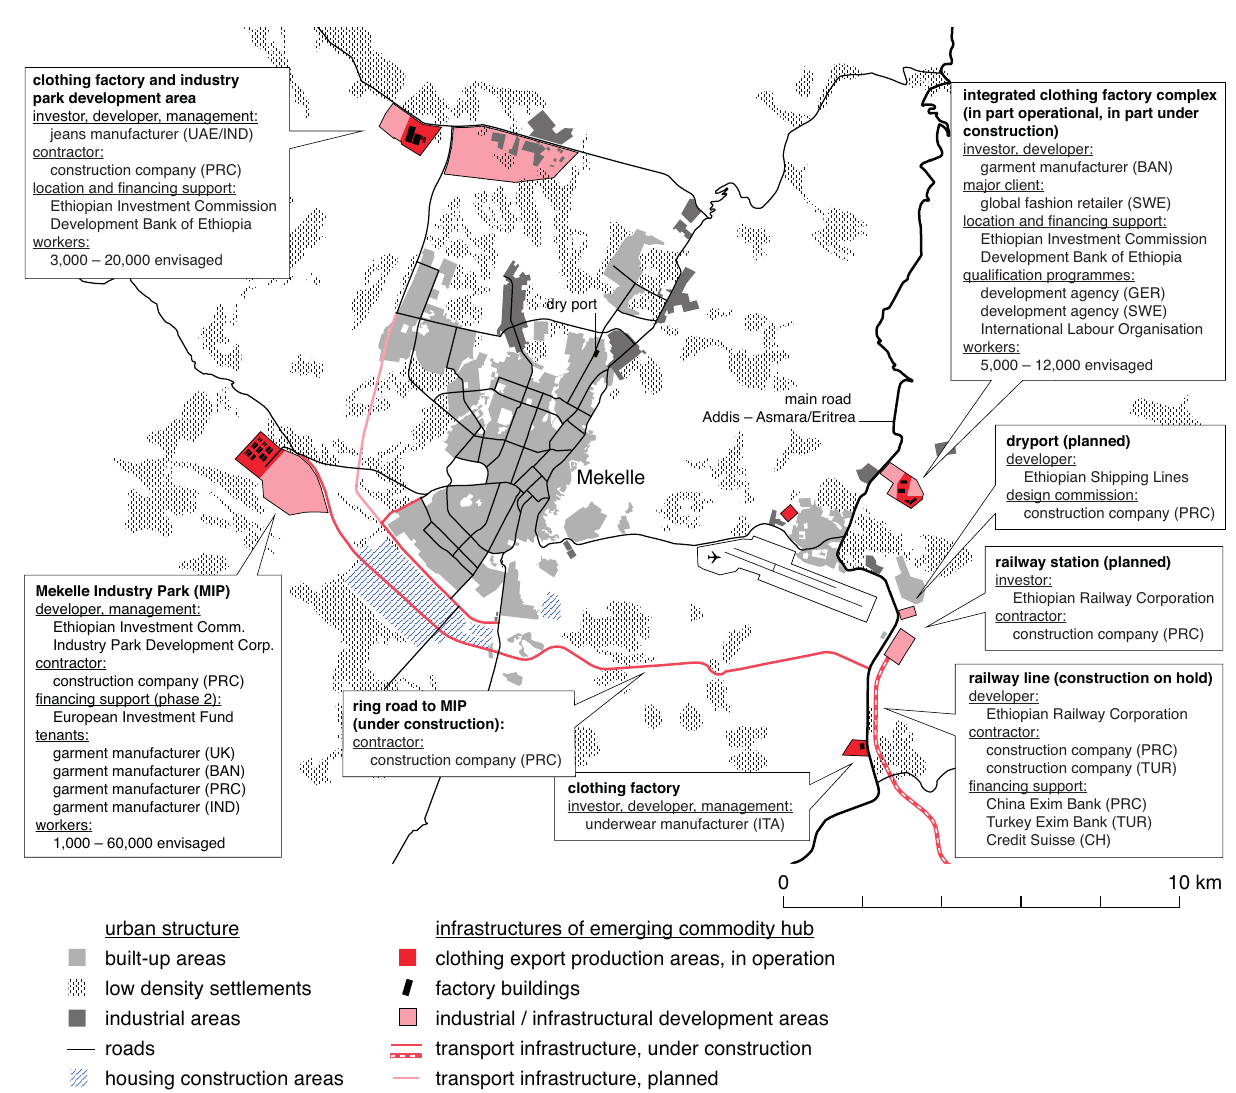
Figure 2. Industry and infrastructure projects for export production in Mekelle and involved actors (2018). Sources: Authors based on Google Maps, OpenStreetMap, IPDC (2015), and authors’